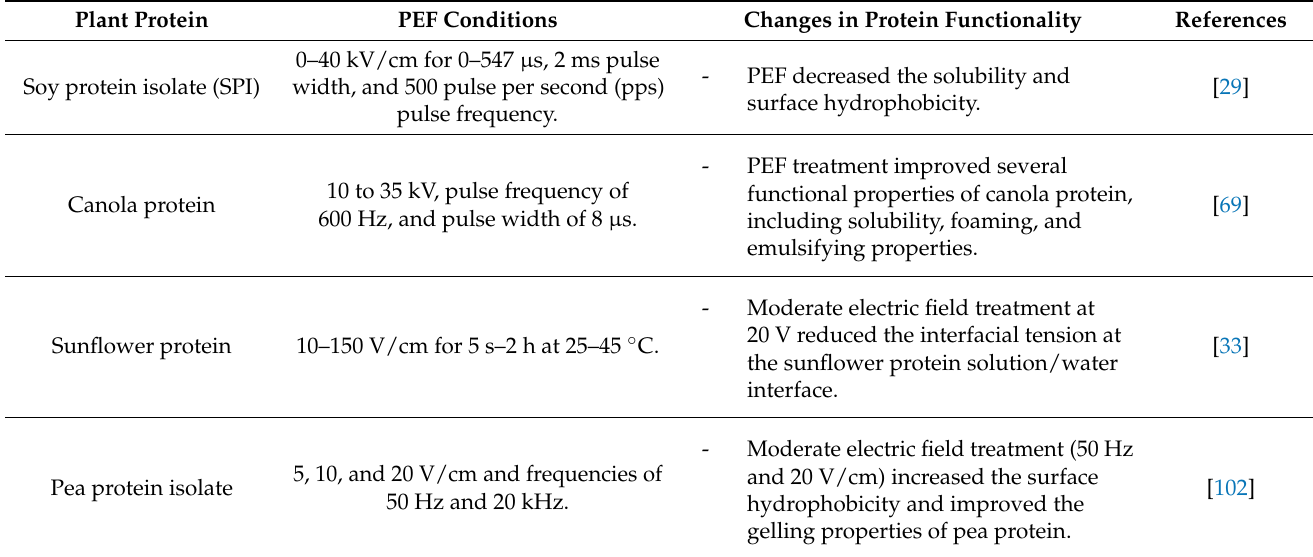
Table 6. Effects of pulsed electric field (PEF) on the techno-functional properties of plant proteins. Plant